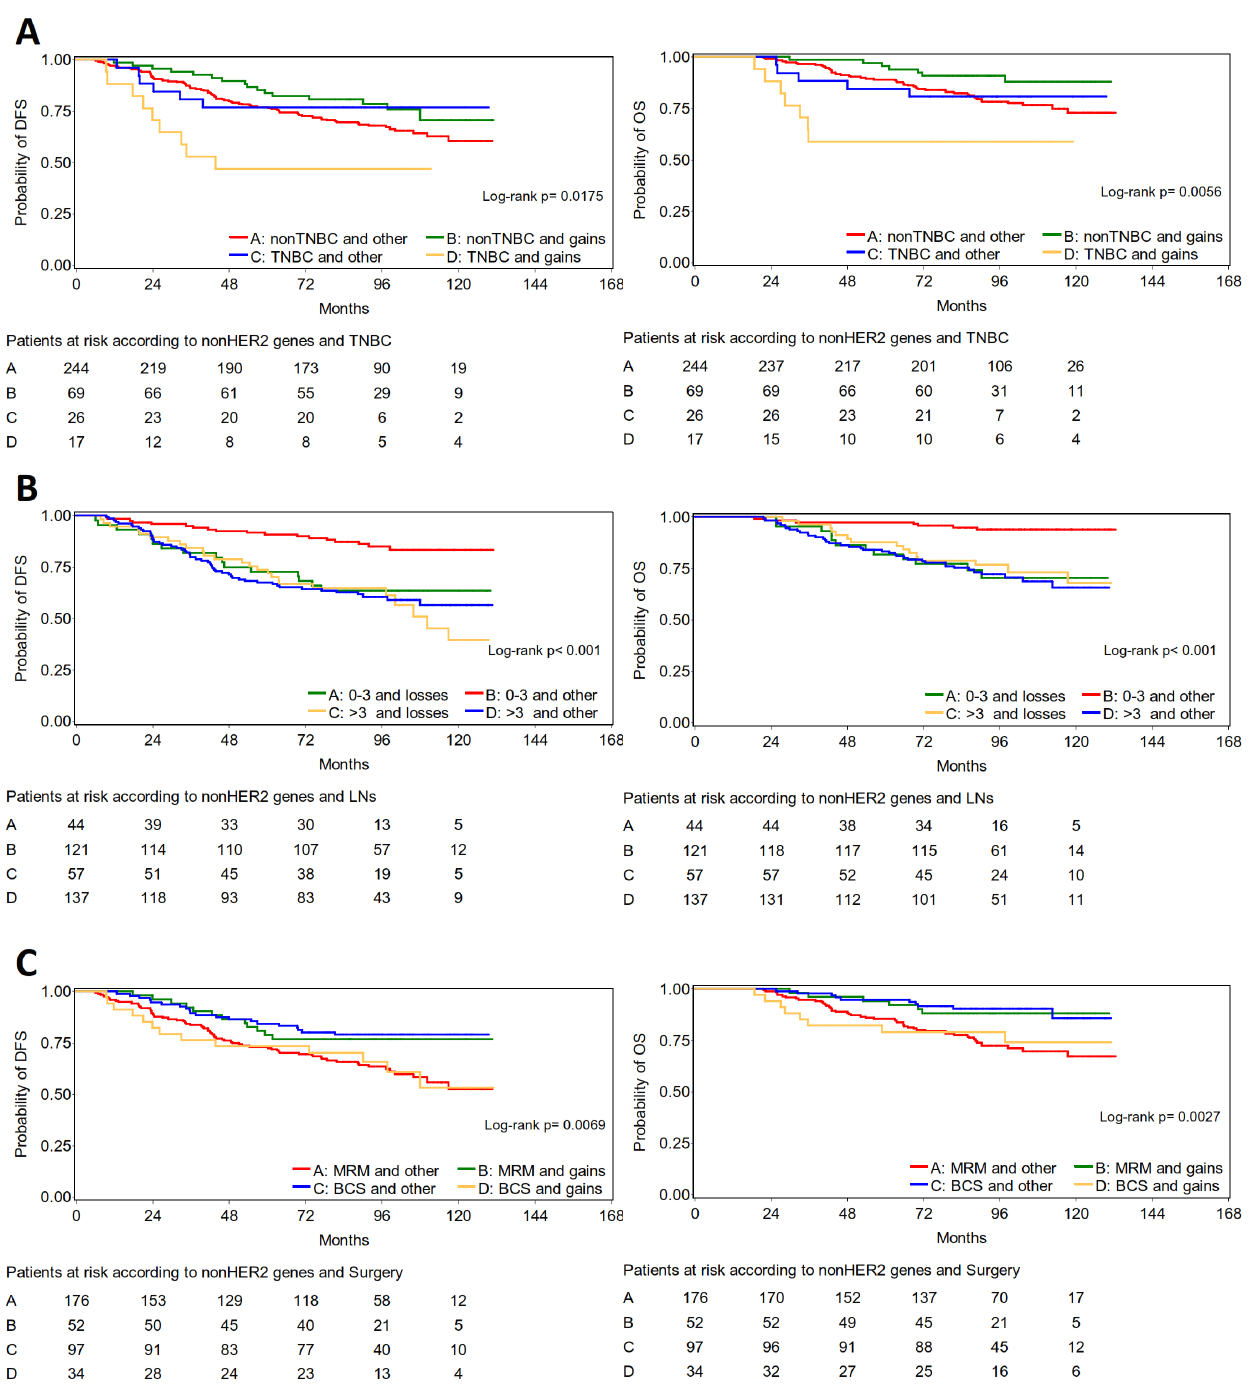
Figure 5. Significant interactions between non-HER2 gene CN clusters and clinicopathologic parameters affecting patient survival. In A, among patients with non-TNBC tumors those with non-HER2 gene CN gains fare best; among patients with TNBC, those with non-HER2 gains fare worse. In B, patients with favorable nodal status (1–3 metastatic lymph nodes) and tumors with non-HER2-gene CN losses have similarly bad outcome as those with unfavorable nodal status. In C, non-HER2-gene CN gains strikingly confer the opposite outcome to patients who have undergone modified radical mastectomy (MRM) as compared to breast-conserving surgery (BCS).